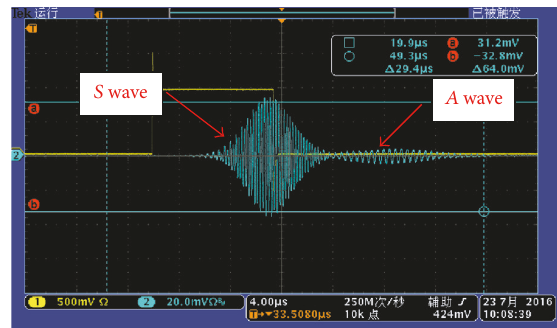
Figure 6: Time-domain signals of KMN-I specimen ( 𝑁 𝑓 = 5 × 10 6 ).